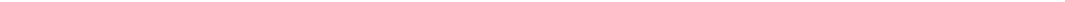
Figure 4: Patient 7, PET/ CT, ultrasound and temporal artery biopsy.Right parietal branch of the temporal artery of patient 7. Sagittal (a) and axial (b) PET/CT image fusion without suspected tracer uptake (arrows) and a negative SUV ratio of 0.7. Ultrasound (c and d) shows a posi- tive compression sign in the parietal (right, black arrows), and negative sign in the frontal branch (left, white arrows) before (c) and during com- pression (d). The parietal branch (right) remains incompressible. A segment of the artery (e) shows dense lymphohistiocytic infiltrates in the media and the adventitia and numerous large multinucleated giant cells (arrows) along the internal elastic lamina. Heavy concentric fibrosis of the intima. (H and E, 100×). On van Gieson elastic stain (200×, f) numerous giant cells are visible along the fragmented and discoloured inter- nal elastic lamina. Fibrosis of the intima (lower right) with only small preserved fragments of the original lamina elastica interna (arrow). Sever- al new layers of thin elastic fibres have formed in the fibrosed